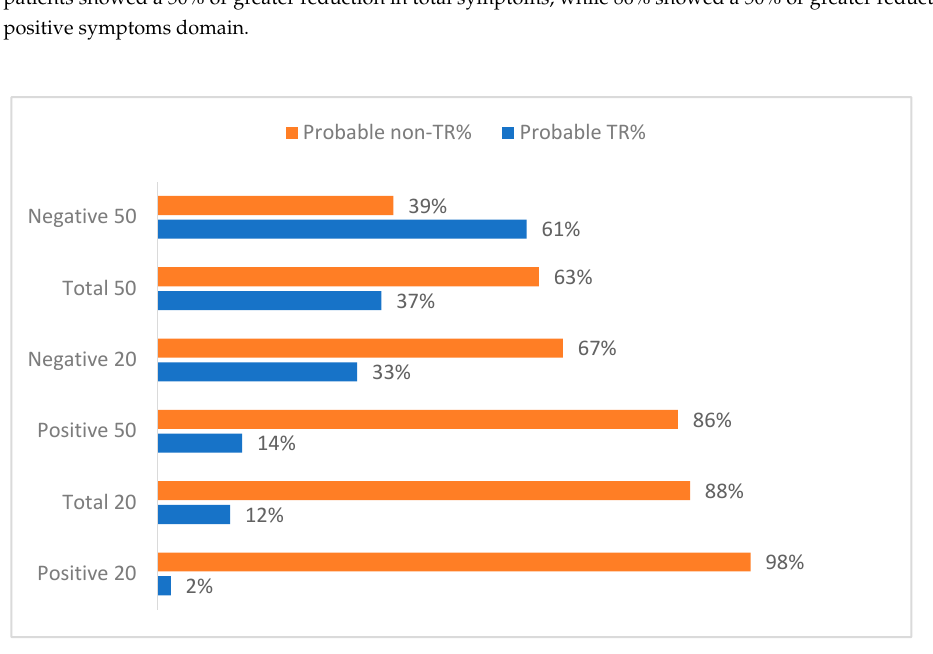
Figure 1. Distribution of probable treatment resistance 6-months after antipsychotic initiation. Across the 3 domains of symptom measures (positive, negative and total), the use of either 20% or 50% cut-off ( y axis) for defining treatment response by 6 months after induction to a first-episode program results in different proportions of patients being identified as probable cases of treatment resistance ( x -axis). Table 2. Rates of Probable TR and mean number of antipsychotic trials using various criteria. Domain